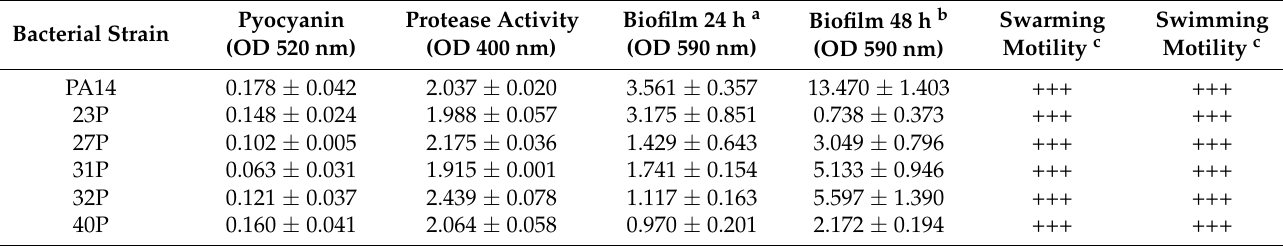
Table 1. Phenotypic characterization of clinical and PA14